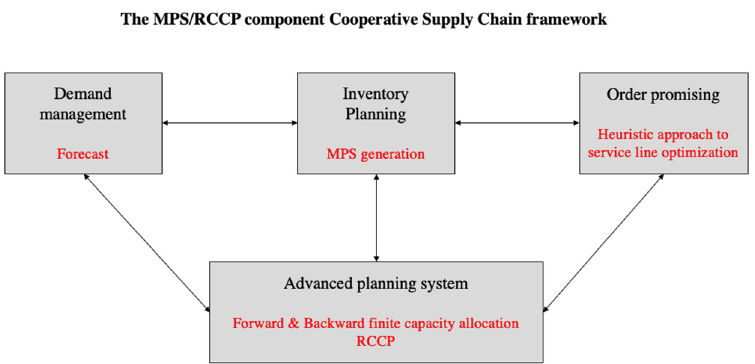
Figure 1. The MPS/RCCP component of the Cooperative supply chain framework .